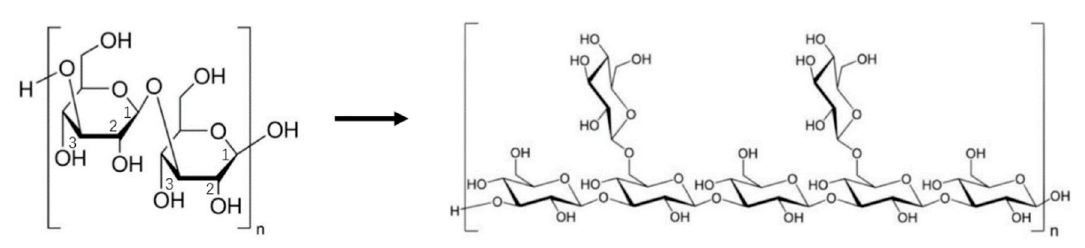
Figure 4. The basic structures of bioactive polysaccharides 1-3,- β - D -glucan and short branched chains with 1-6,- β -linkage.